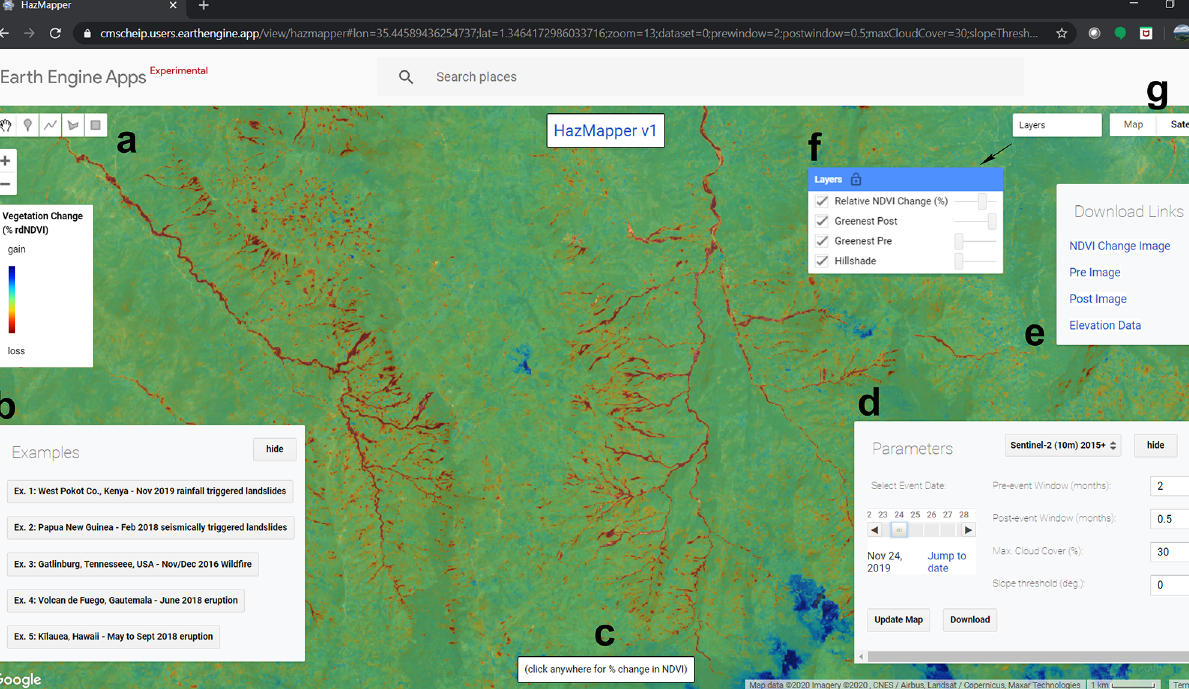
stricken locations. The basemap options are Google’s